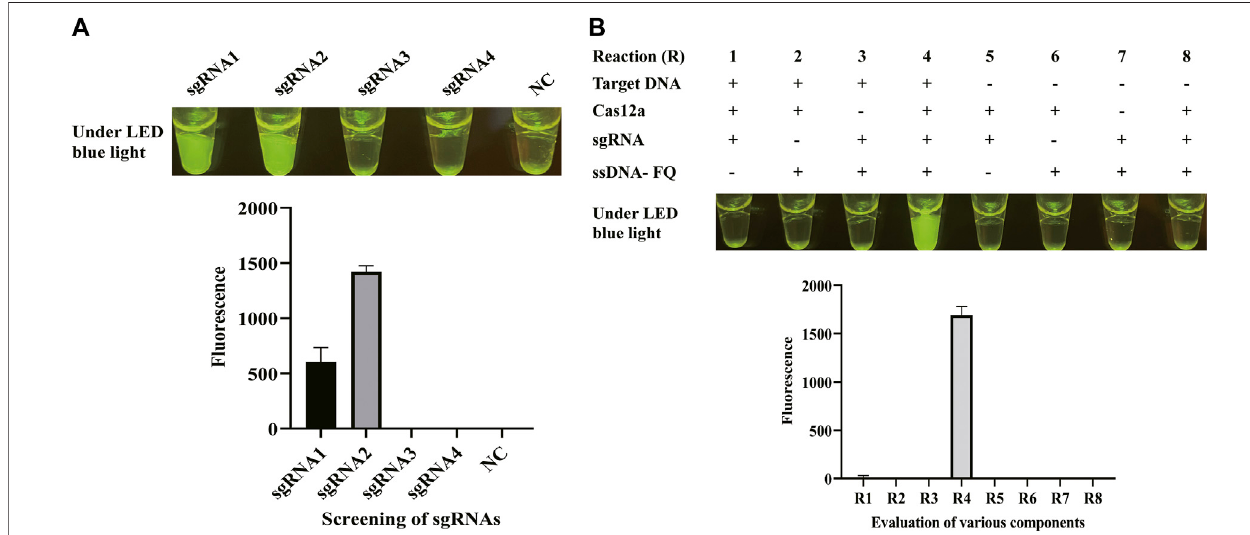
FIGURE2| sgRNAscreeningandevaluationofvariouscomponents. (A) FoursgRNAsweredesignedbasedonthetargetsequenceandusedforthescreeningof sgRNAs in the CFX96 Touch Real-Time PCR Detection System. The results were shown by endpoint fl uorescence photography and endpoint fl uorescence intensity; NC,negativecontrol. (B) Variouscomponentswereevaluatedthroughendpoint fl uorescencephotographyafter30-minincubationandreal-time fl uorescencedetection. The LAMP products, Cas12a, sgRNA, and ssDNA-FQ reporter were tested. The results were shown by endpoint fl uorescence photography and endpoint fl uorescence intensity.